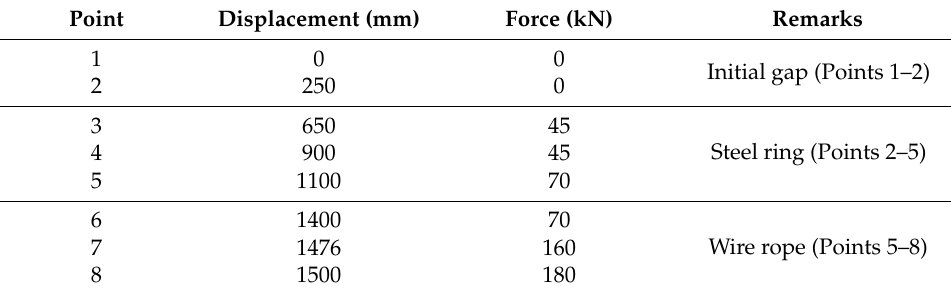
Table 2. Force-displacement relationship for equivalent model.